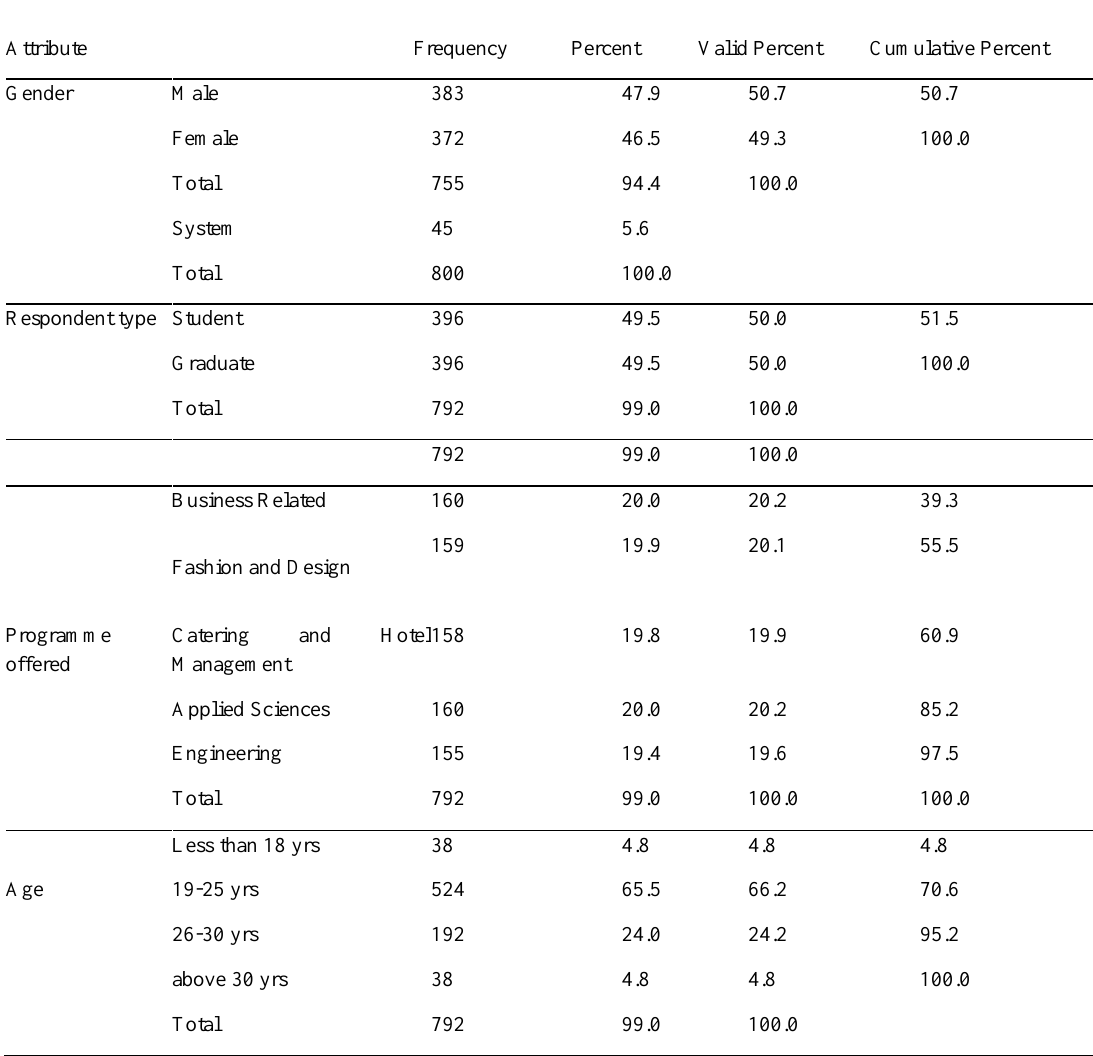
Table A1: Sample Distribution of Respondents for the Study